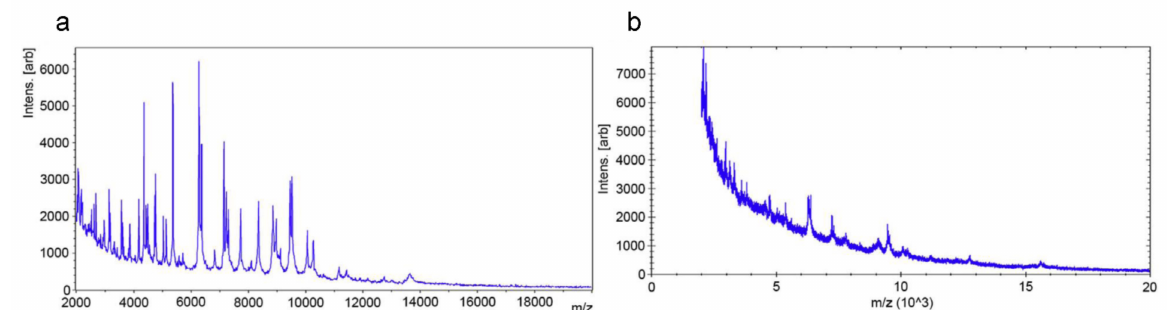
Figure 2. Differentiation between resistant and susceptible isolates by matrix-assisted laser desorption ionization time-of- flight mass spectrometry (MALDI-TOF MS) spectra after antibiotic incubation. ( a ) Meropenem-resistant Klebsiella pneumoniae isolate. ( b ) Meropenem-susceptible isolate. Reprinted from reference [61] with